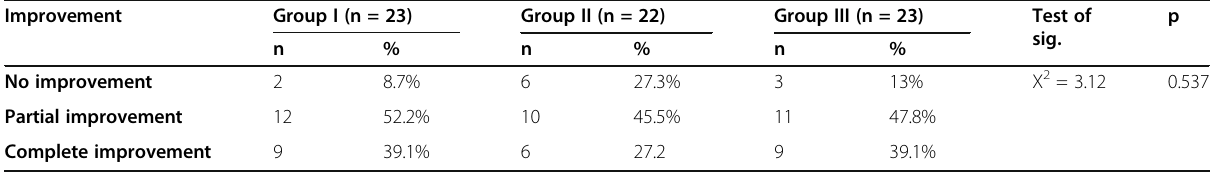
n number of patients, % percentage X 2 and p values for the chi-square test for comparing the three groups *Statistically significant at p ≤